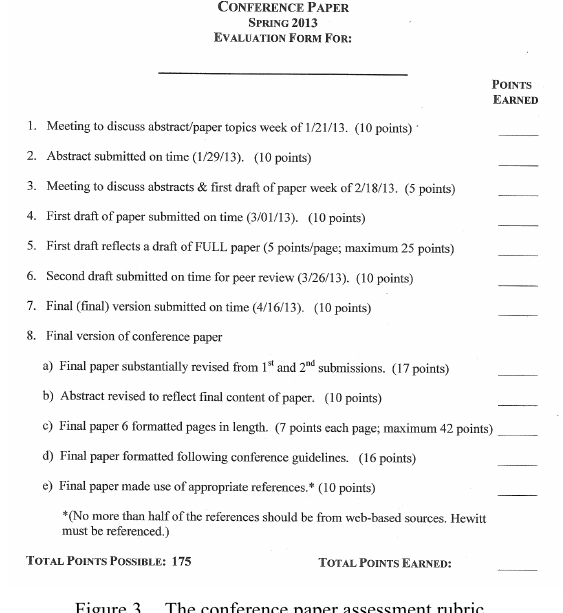
Figure 3. The conference paper assessment